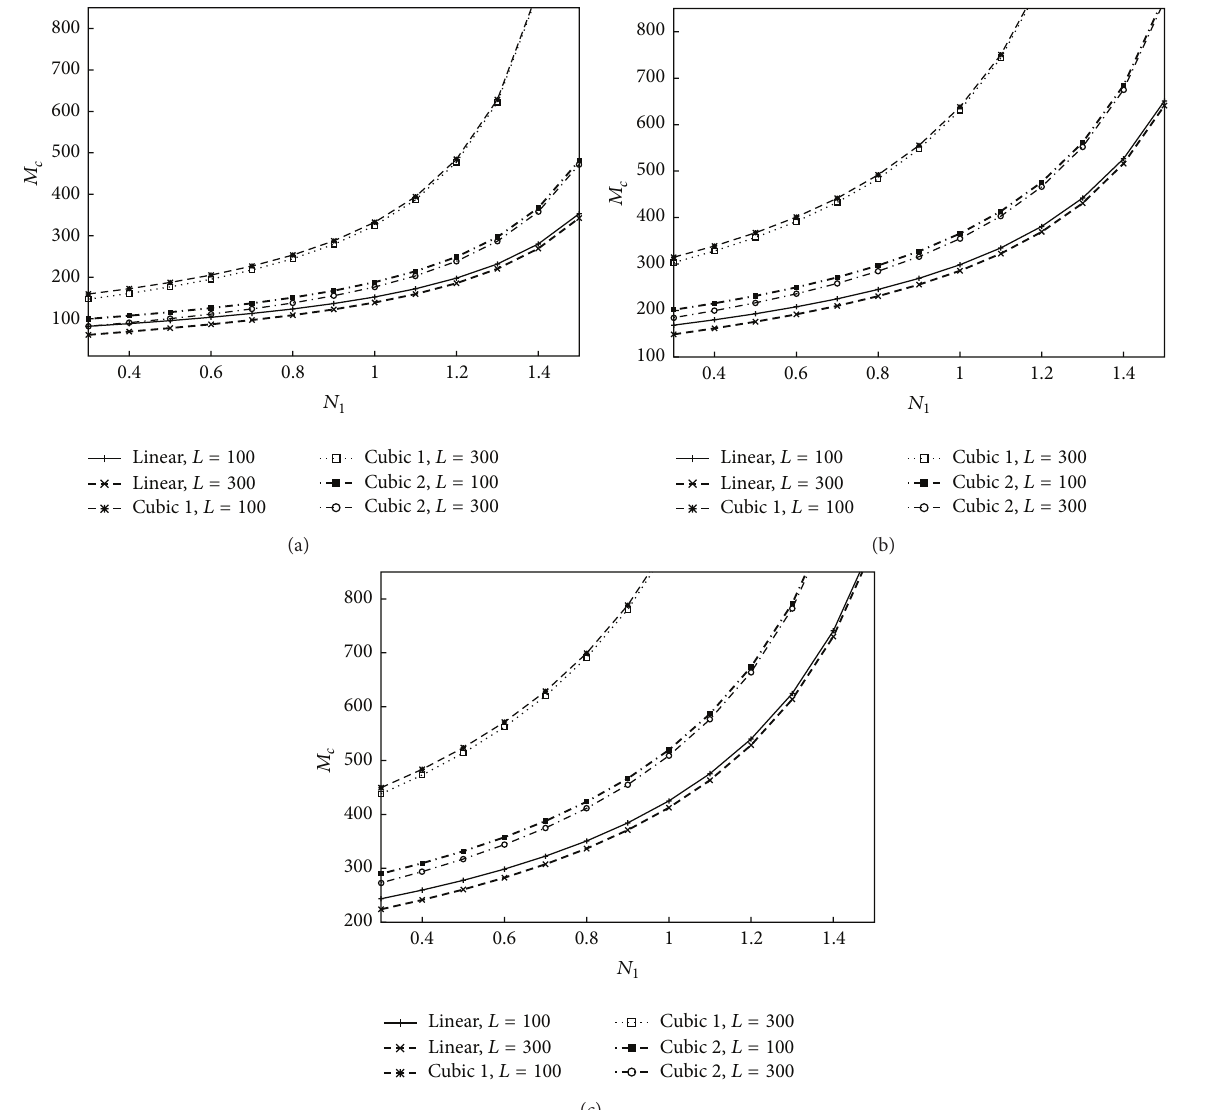
Figure 2: Plot of critical Marangoni number, 𝑀 𝑐 , versus couple parameter, 𝑁 1 , for different electric number, 𝐿 , and (a) 𝐾 = 0 , (b) 𝐾 = 4 , and (c) 𝐾 = 8